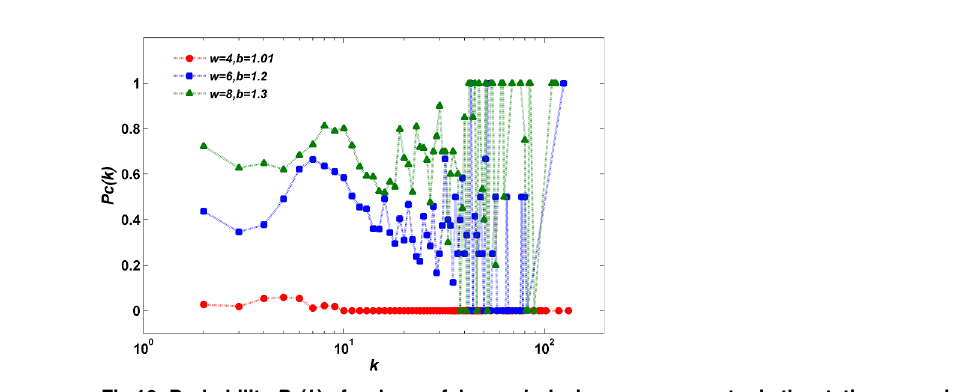
Fig 10. Probability P C ( k ) of a player of degree k playing as a cooperator in the stationary regime of evolutionary dynamics. The randomselectionrule is appliedand l =